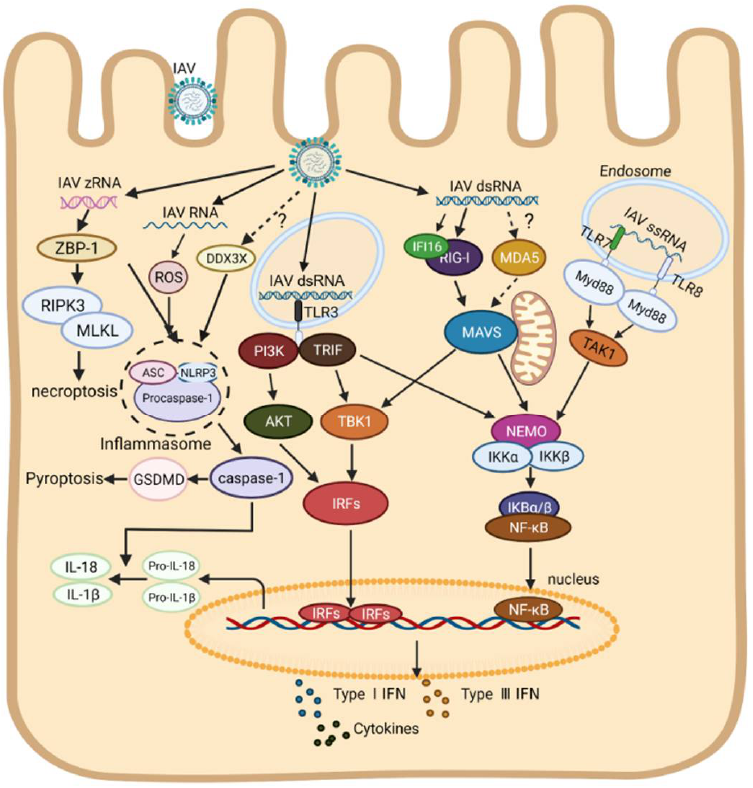
Figure 1. Schematic diagram of innate immune response caused by IAV RNA. Upon IAV infection, viral ssRNA in the endosome is sensed by TLR7/8 and recruits the MyD88 adapter. Activated MyD88 induces the production of inflammatory cytokines through the TAK1-IKK-NF- κ B signaling pathway. Viral double-stranded RNA in the endosome is sensed by TLR3, which further recruits TRIF and PI3K adapters, inducing the production of IFN through the TAK1-IRFs signaling pathway. Viral dsRNA in the cytoplasm is sensed by RIG-I and IFI16, leading to activation of NF- κ B and phosphorylation of IRFs by binding to MAVS on mitochondria. Furthermore, IAV RNA can be sensed by NLRP3, which promotes the formation of inflammasomes, causing pyroptosis and secreting the IL-1 β and IL-18. Of note, there is no direct evidence to demonstrate that IAV RNA can be recognized by DDX3X and MDA5 in mammals, which is indicated by dotted lines. Abbreviation: ROS, reactive oxygen species; MLKL, mixed lineage kinase domain-like pseudokinase. Other abbreviations are shown in the legend to Figure 2.